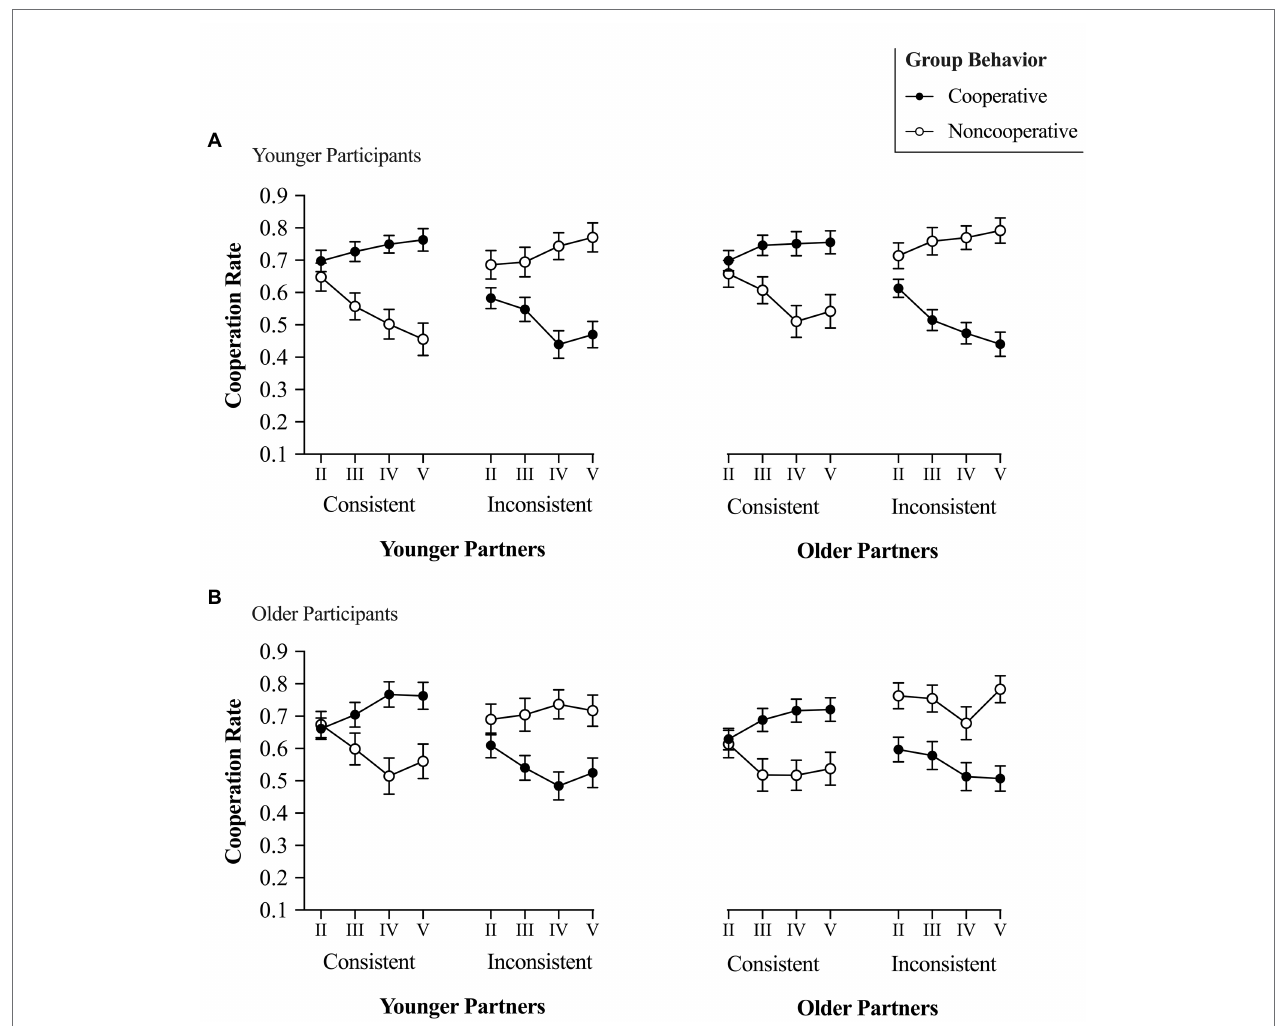
FIGURE 2 | Cooperation rates in the learning phase as function of partners’ consistency (consistent vs. inconsistent) and group behavior (cooperative vs. noncooperative) for (A) younger and (B) older participants. Error bars represent the error standard of the